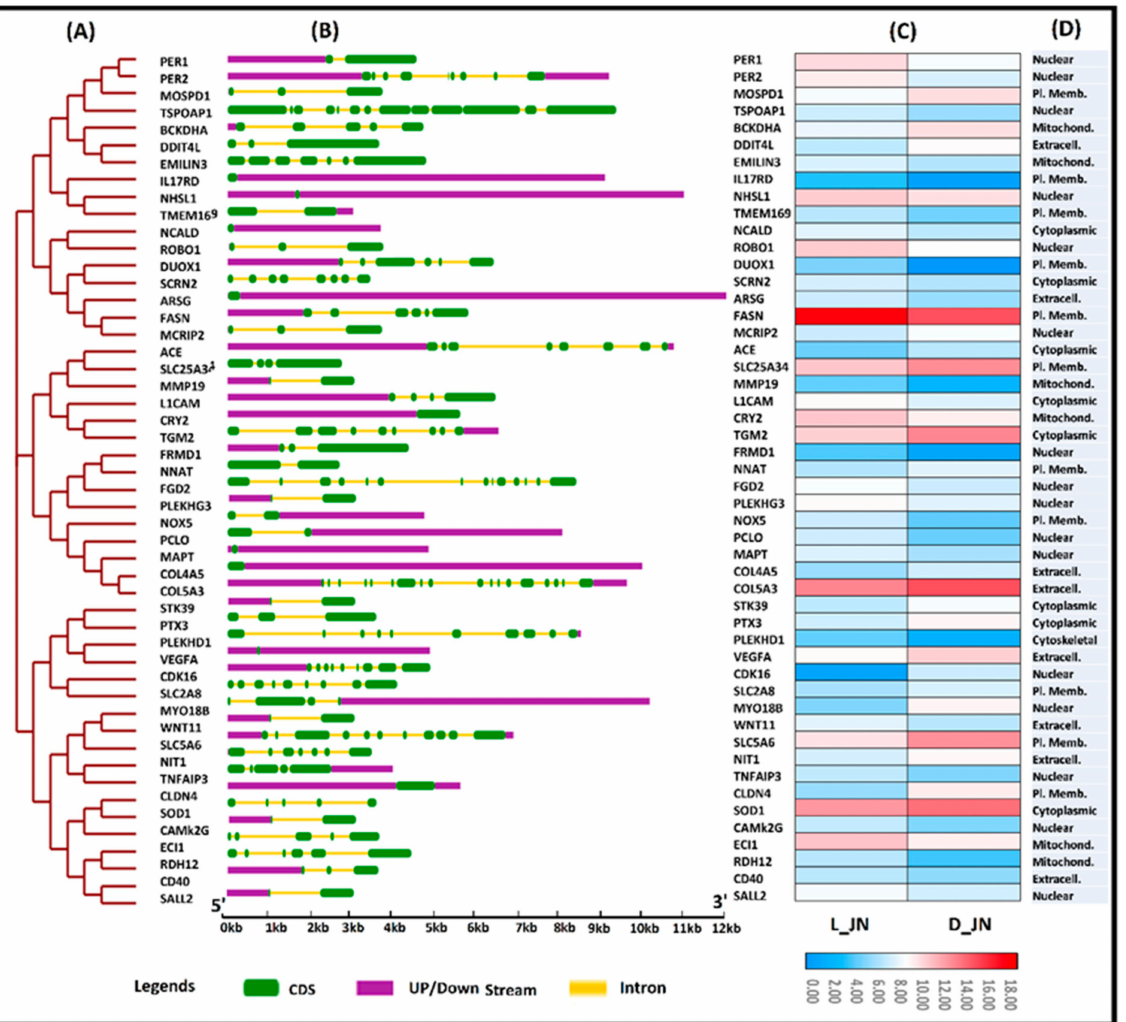
Figure 7. Relationship between gene structures, subcellular localization, and expression patterns among differentially expressed target genes of IMF-associated CircRNAs; ( A ) represents the phy- logenetic tree built with the neighbor-joining method and 1000 bootstrap replicates; ( B ) shows the gene structure of target genes containing different numbers of exon and introns; ( C ) demonstrates the expression profiles of IMF-associated target genes based on FPKM values; ( D ) shows the subcellular localization of all target